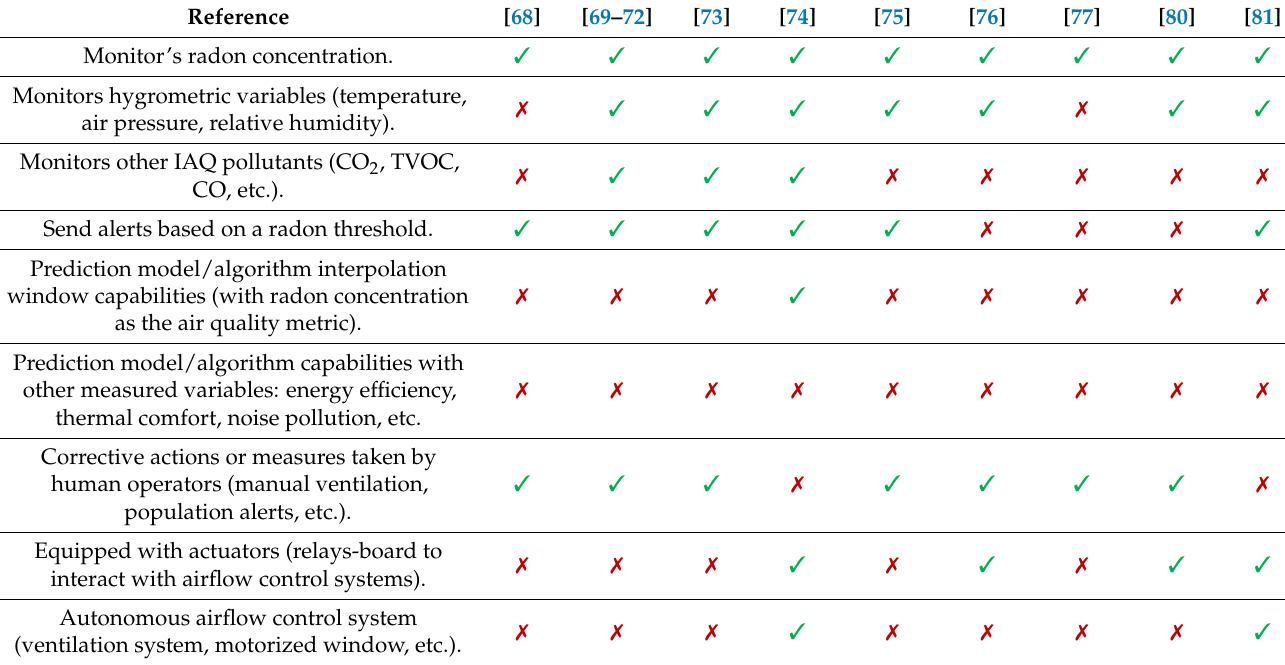
Table 3. Monitoring systems-summary of most relevant characteristics.